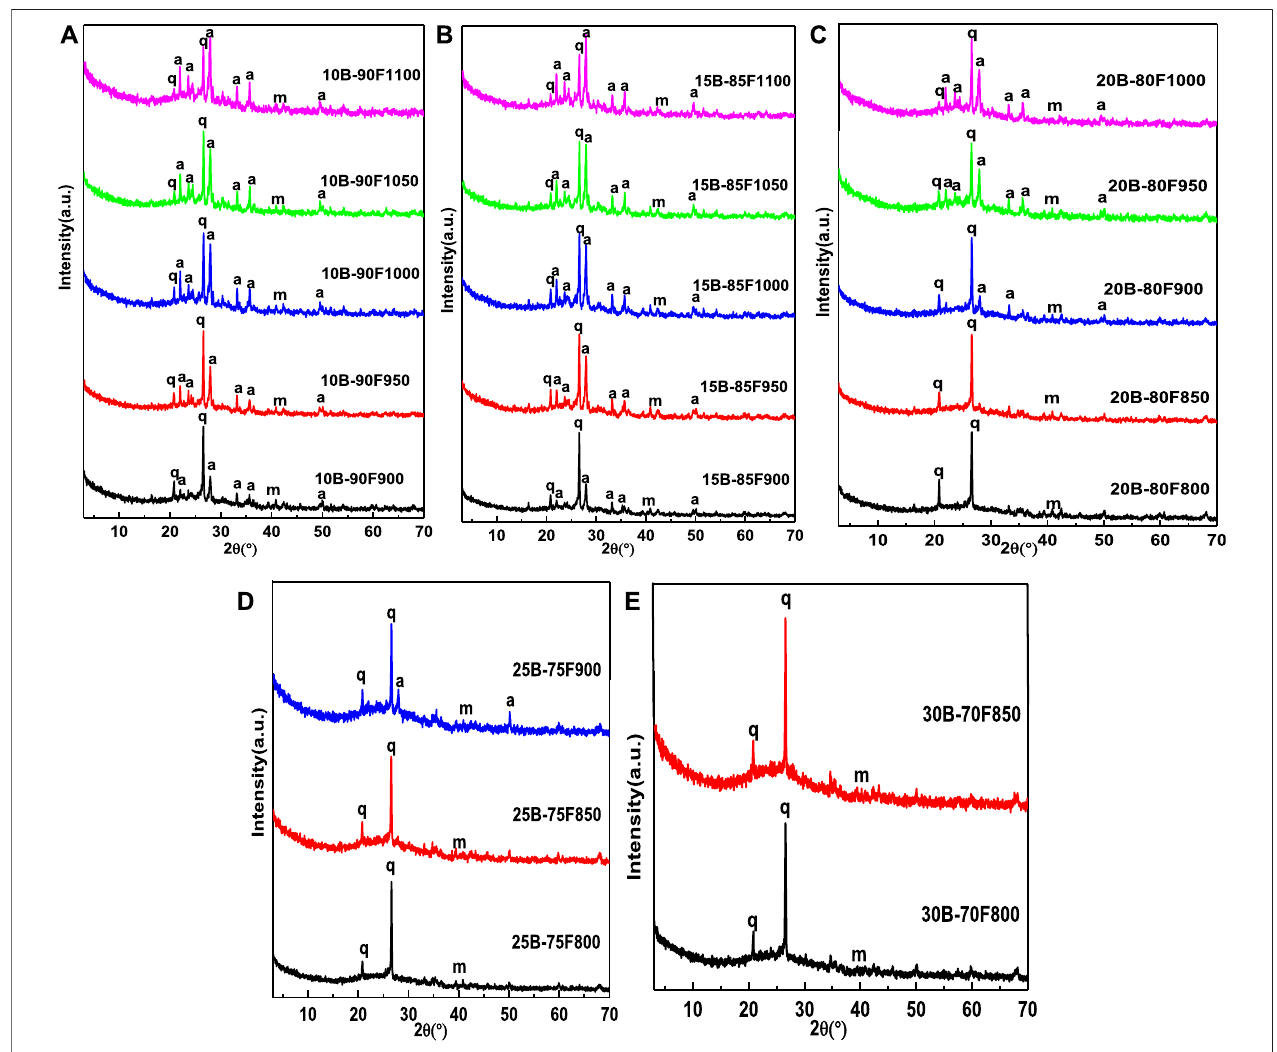
FIGURE 2 | XRD patterns of sintered samples with different borax additions at different temperature (q-quartz, m-mullite, a-anorthite).